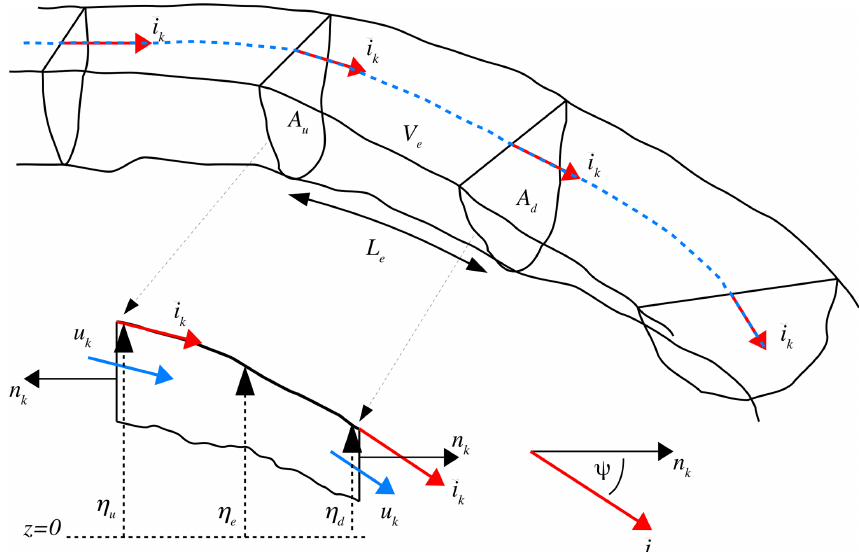
Figure 1. General arrangement of control-volume element ( V e ) and its neighbors for the irregular channel. Unit normal vectors n k are always perpendicular to cross-sectional areas ( A u , A d ) and pointing outward from control volume. The element length ( L e ) is measured along the channel. Unit vectors ˆ i k are coincident with the free-surface slope in the streamwise direction and can be defined as local continuous functions. The velocity vector u k is approximated as parallel to ˆ i k . The angle measured from n k to ˆ i k is ψ . The free-surface elevations η u , η e , and η d are cross-section uniform elevations at the upstream face, for the element center, and the downstream face, respectively. Note that volume is V throughout the derivations with u and U used for continuous and spatially averaged velocities,